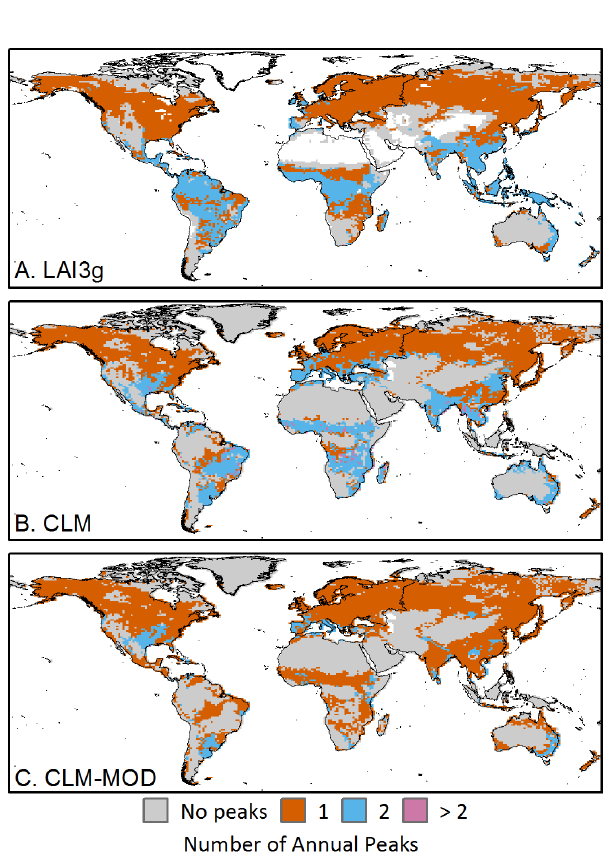
Figure 7. Mode of annual peak count analysis for the three simula- tions. (a) LAI3g; (b) CLM; (c) CLM-MOD.